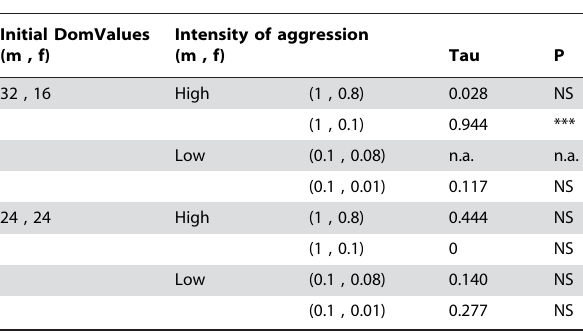
Table 1. Kendall correlation (Tau) between female dominance and the proportion of males in a group for different initial dominance values and intensities of aggression (average of 40